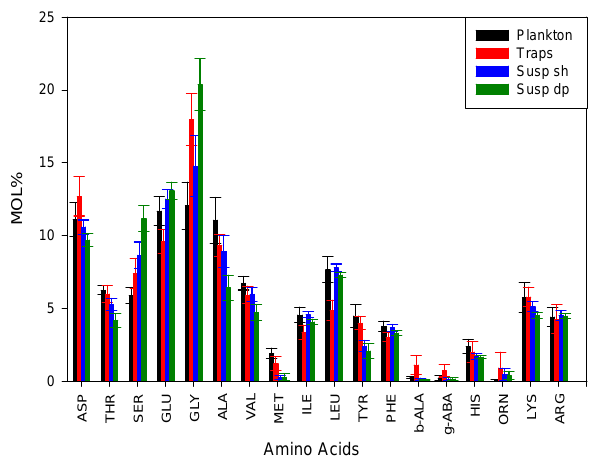
Fig. 5. Results of the PCA carried out on AA spectra (Mol%) of SPM, plankton and trap samples from the Arabian Sea. Symbols in- dicate the Site scores of individual plankton (crosses), SPM (boxes), and trap samples (triangles). Factor loadings of individual AAs mul- tiplied by 10 are indicated by red AA abbreviations. AAs typical of fresh plankton are marked with a hexagon, AAs enriched with depth on SPM are encircled and arrows indicate increasing sam- pling